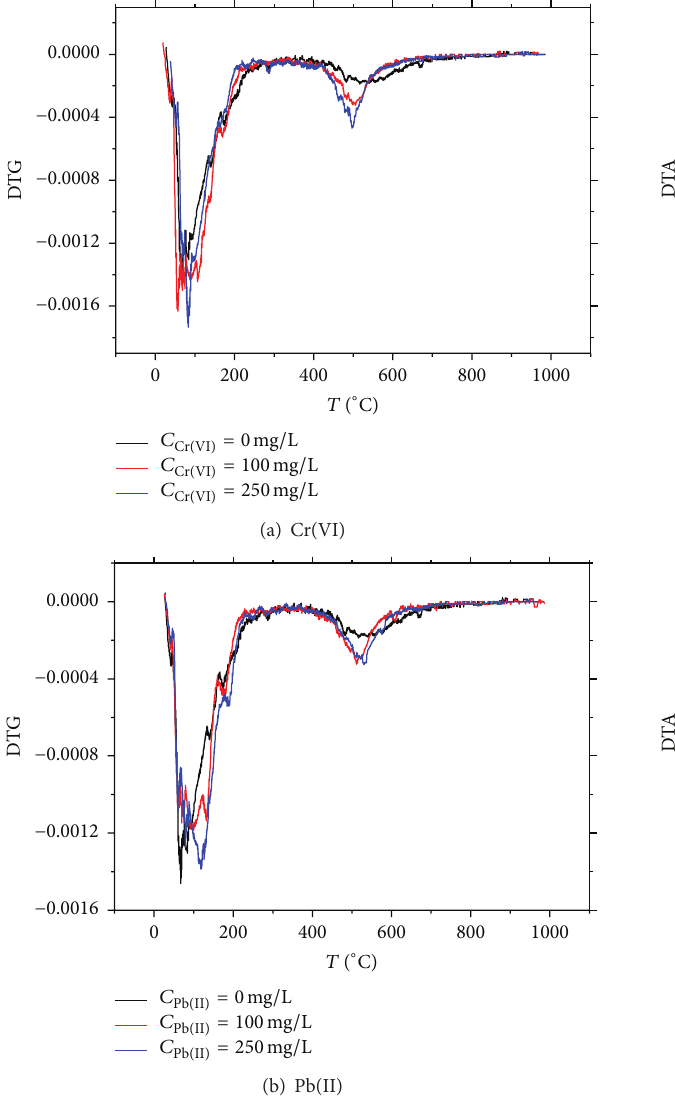
Figure 11: Differential thermal analysis curvilinear (DTA-T curvi-